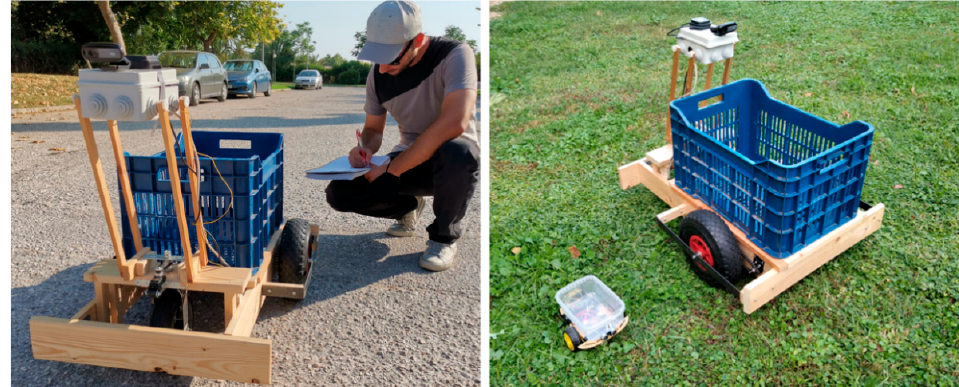
Figure 1. The proposed agricultural robotic should be of a realistic size, and thus of a comparable performance with a human ( left ), and much larger than a typical STEM artifact ( right ), even if they share many design principles.